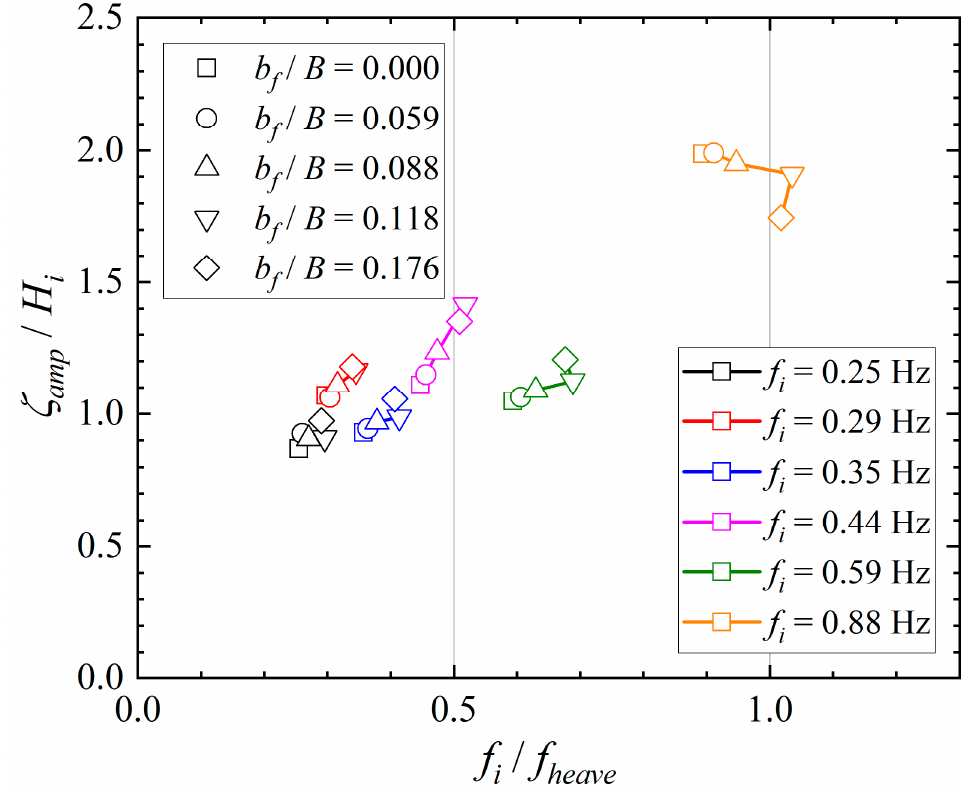
Figure 7. Relationship between ζ amp / H i and f i / f heave for the heave motion.